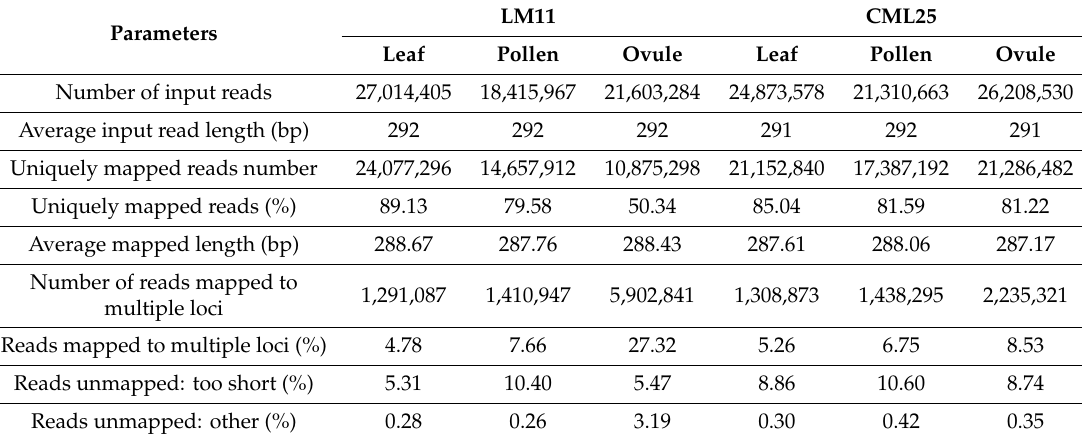
Table 1. Summary statistics of LM11 and CML25 reads mapped to B73 reference